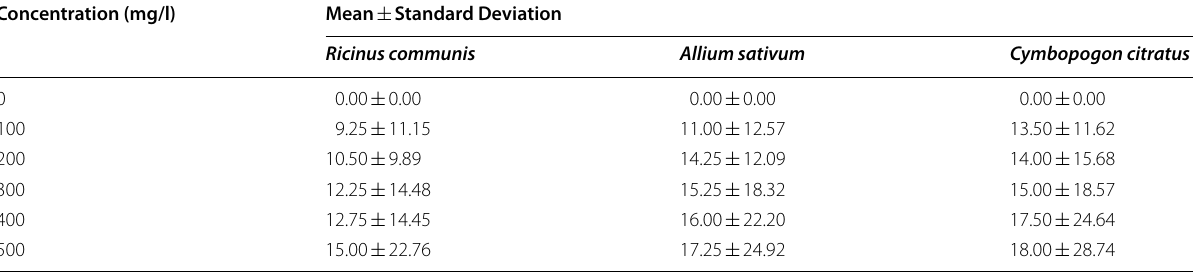
Table 1 Mean mortality values of ethanolic leaf extracts of r. communis, a. sativum and c. citratus at different concentrations Concentration